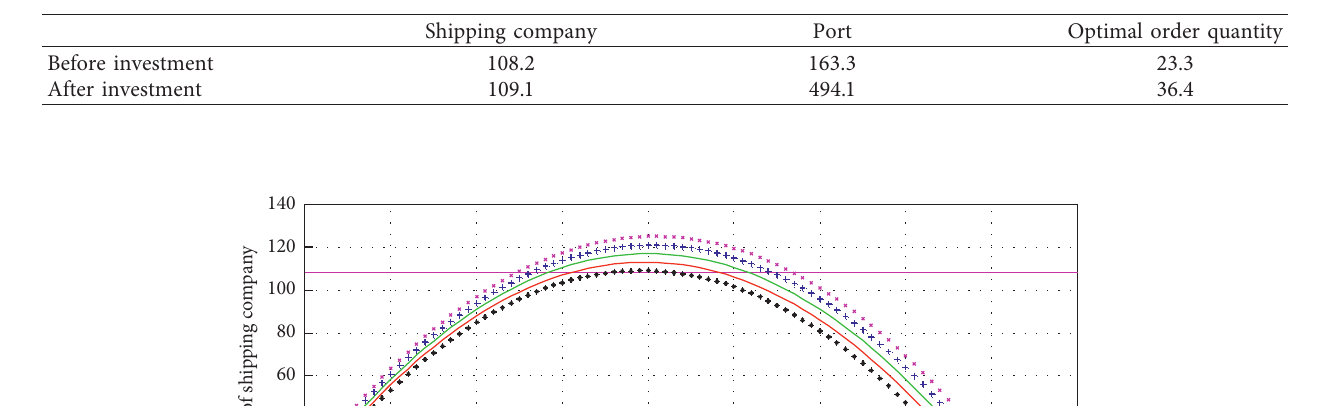
Table 2: Profit before and after